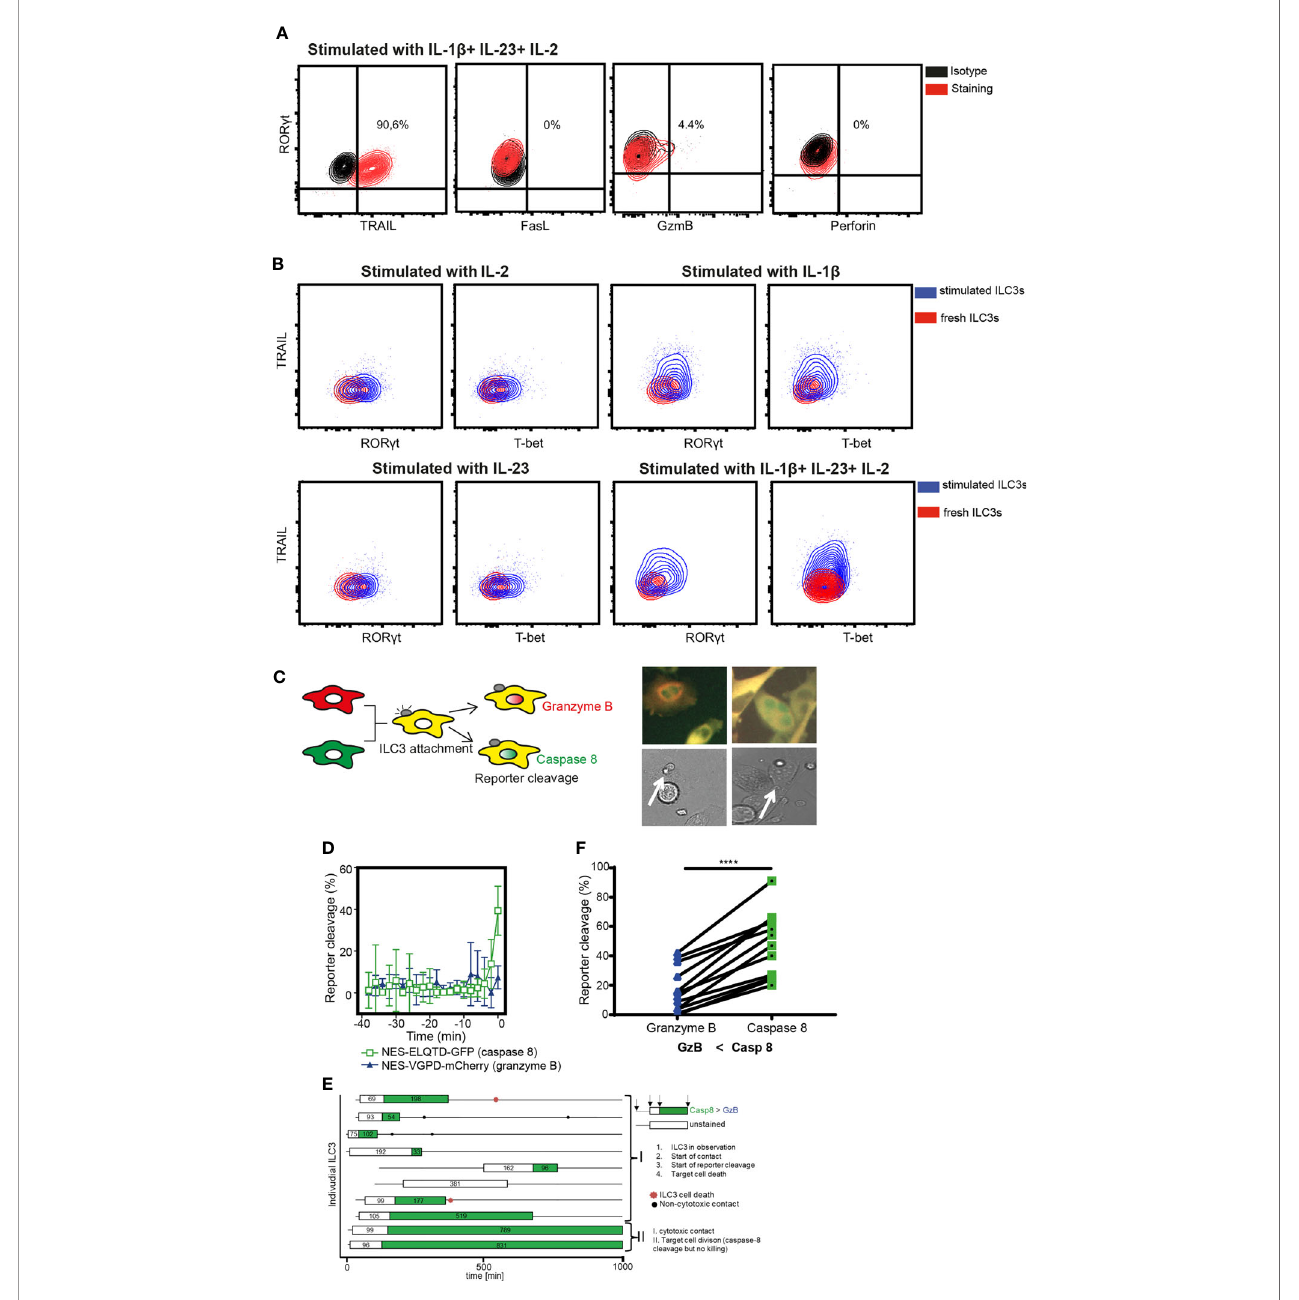
FIGURE 3 | ILC3 cytotoxicity is mediated by Caspase-8. (A) Representative contour plots of TRAIL, FasL, Granzyme B and Perforin expression by ILC3s stimulated with indicated cytokines overnight. (B) Expression of TRAIL, ROR g t and T-bet in freshly-isolated or in ILC3s stimulated with IL-1 b , IL-23 and 10 U/ml IL-2 independently or combined. Data are representative of 2 different donors. (C) Cytokine-stimulated ILC3s were co-cultured with HeLa target cells expressing the NES-ELQTD-GFP-T2A-NES-VGPD-mCherry construct. Schematic representation of cytoplasmic and nuclear fl uorescence signals in HeLa cells upon Granzyme B (GrzB) or Caspase-8 (Casp8) activation (left). Two examples of HeLa target cells with green nuclear signal upon interaction with ILC3 (white arrows), indicating Casp8 activity. (D) Four individual HeLa target cells were tracked over time and average reporter cleavage calculated upon contact with ILC3s (time point 0 set to time of cell death); mean ± SD. (E) Ten individual ILC3s were tracked over time. Each line represents one ILC3, every box visualizes ILC3-target cell contact, the length of the box displays the duration of the contact, and the color represents the reporter cleavage (green: Casp8 > GrzB). Non-cytotoxic contacts were indicated by black dots, and ILC3 cell death by a red star. (F) Quanti fi ed reporter cleavage at the time of maximum target cell death in 11 HeLa target cells upon contact with ILC3s (n=2 blood donors). ****p <0.0001, by paired Student ’ s